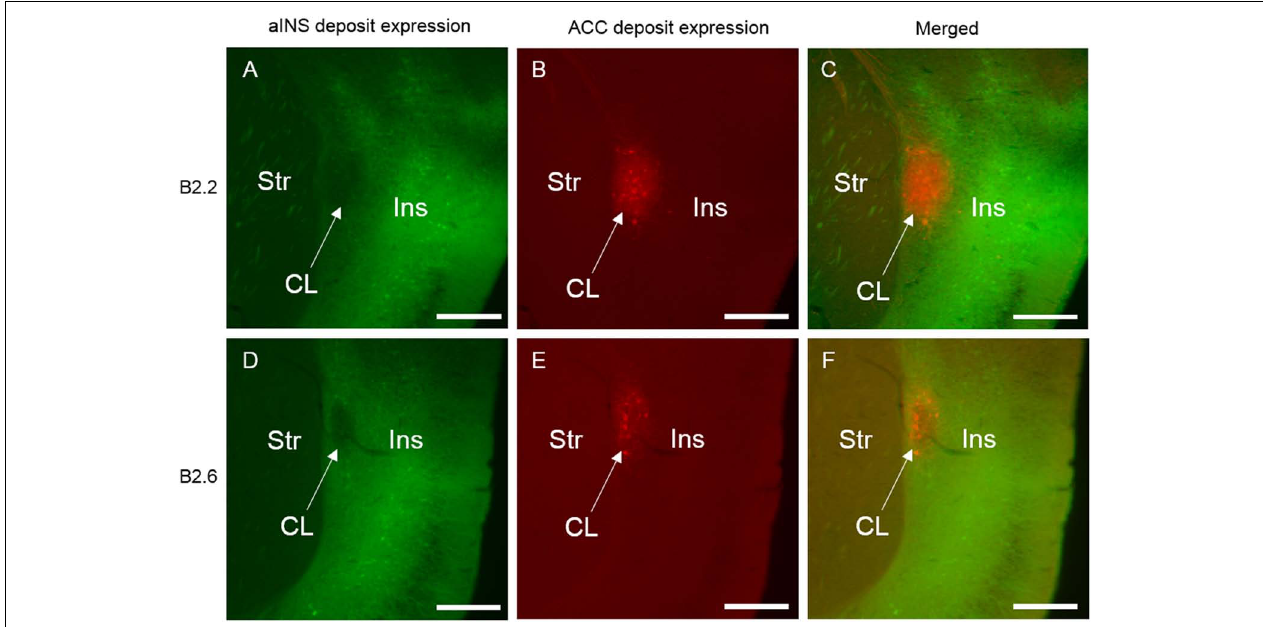
FIGURE 6 | Selected photomicrographs of the caudal level of the claustrum and surrounding regions for case B2.2 (A–C) and B2.6 (D–F) (AP = + 0.14 mm from bregma), illustrating retrograde and anterograde labeling following aINS and ACC viral injections. Merge of panels (A) and (B) is shown in (C) . Merge of (D) and (E) is shown in (F) . Scale bar: 500 µ m. Str, striatum; CL, claustrum; Ins, insular